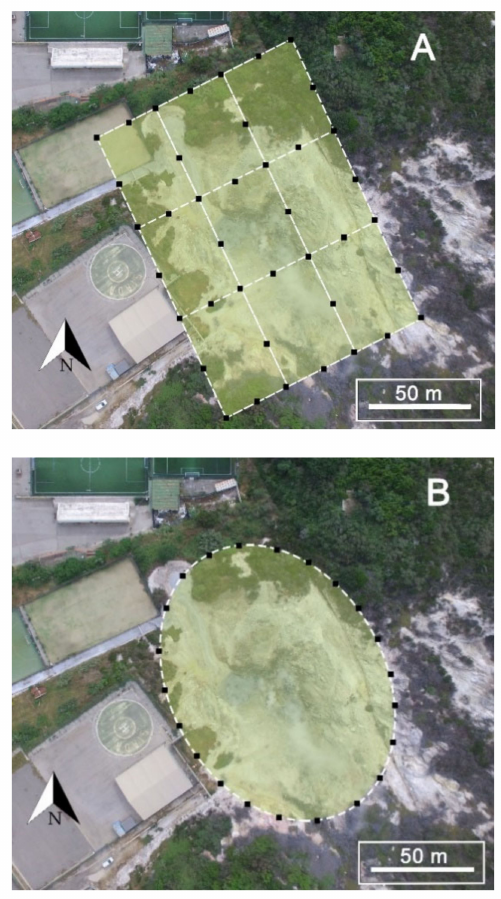
Figure 4. Rectangular ( A ) and elliptical ( B ) waypoint acquisition